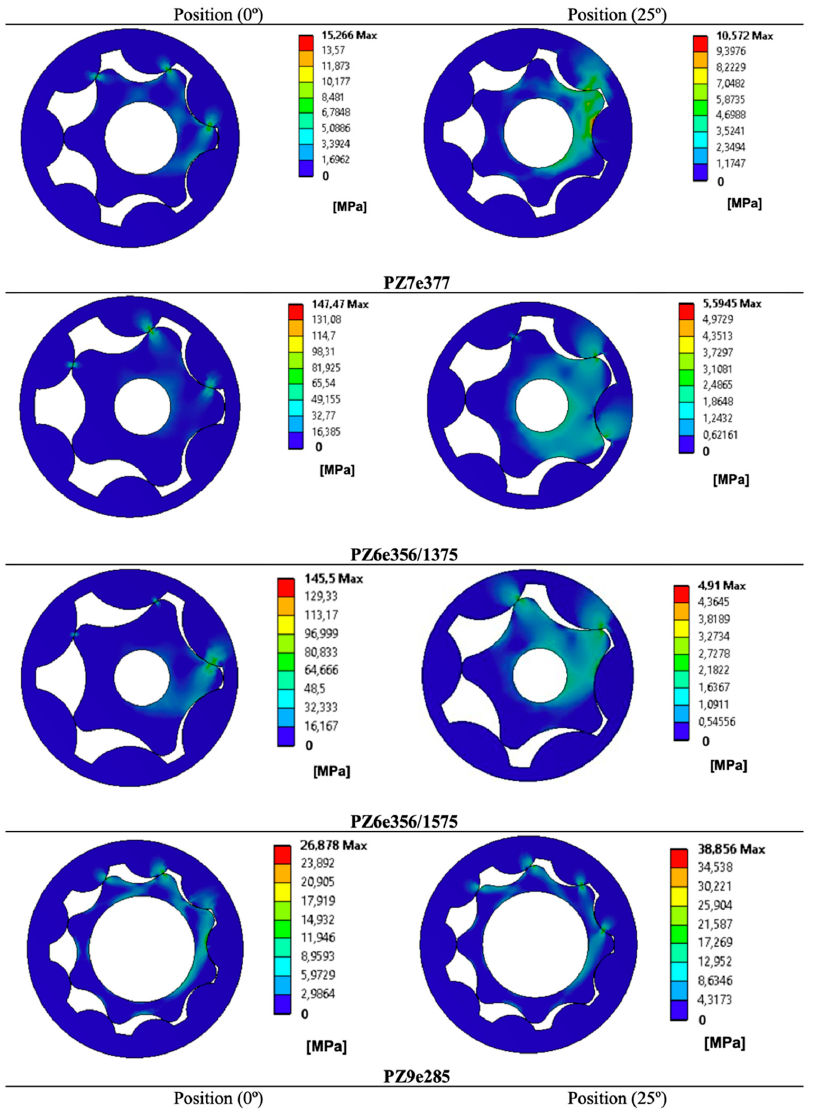
Figure 3. Authors’ FEM results of maximum contact stress [MPa] in each gear set from researchers’ works at 0° and 25° angular positions. (The commas in this specific figure represents decimal dots. For interpretation of the references to color in this figure legend, the reader is referred to the Web version of this article.).